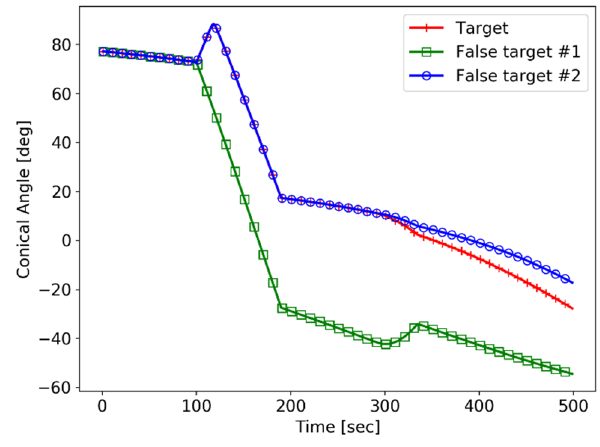
Figure 7. The conic angle trajectories.